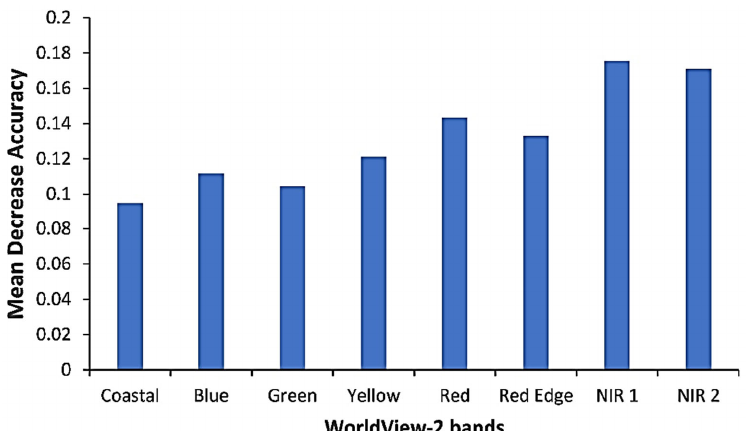
Figure 6. The relative importance of WorldView-2 bands in discriminating between different tree species as measured by RF classifier.